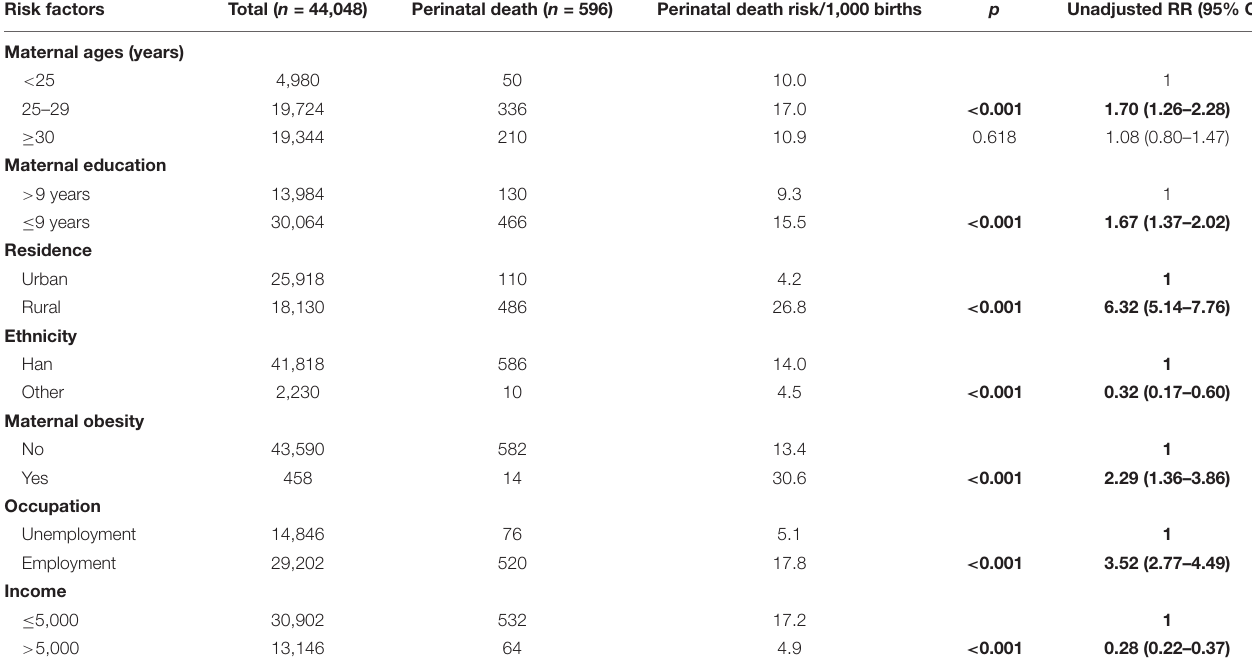
TABLE 1 | Sociodemographic characteristics and unadjusted relative risk (RR) for perinatal death among 44,048 pregnant women. Risk